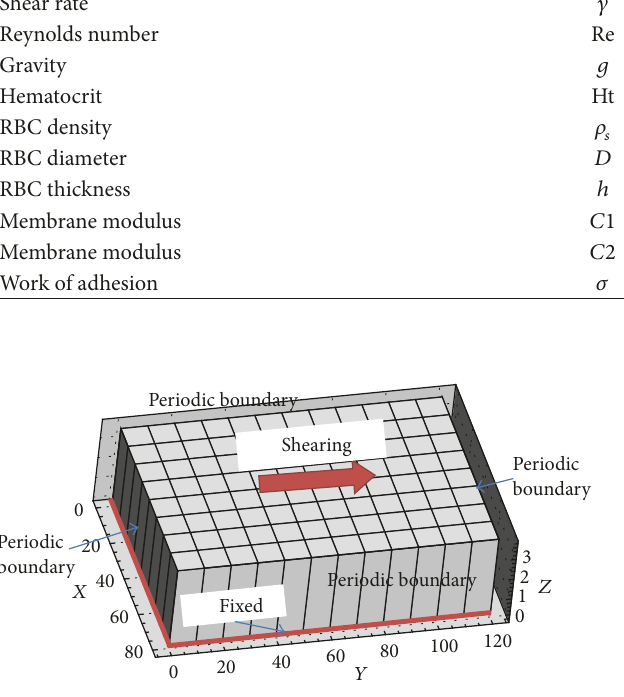
Figure 8: Computational domain and boundary conditions of the simulation (all coordinates were normalized with RBC diameter).